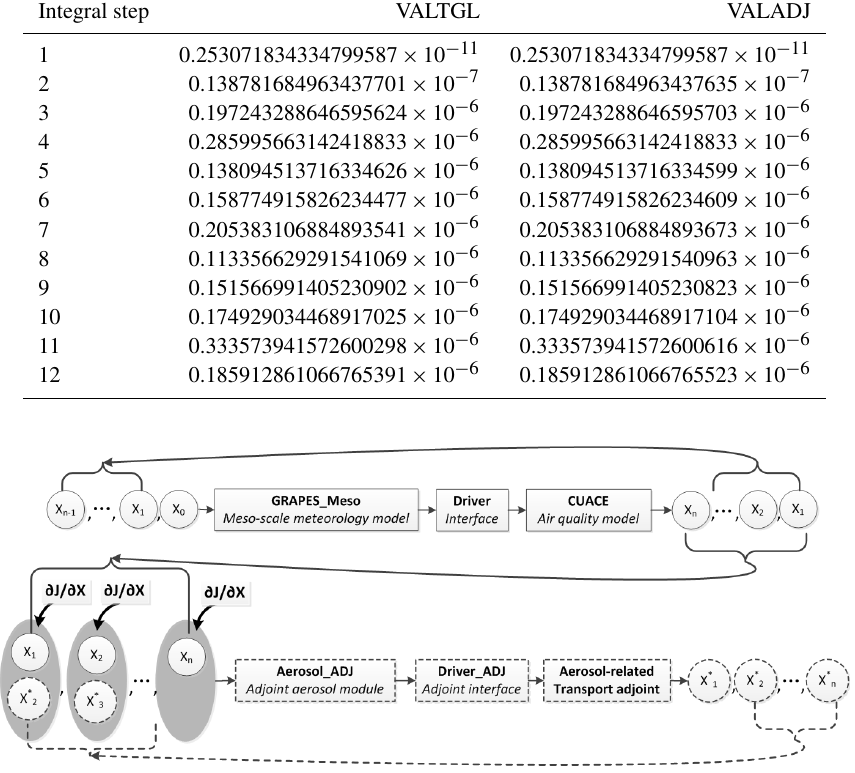
Table 2. Validation results of the adjoint model.